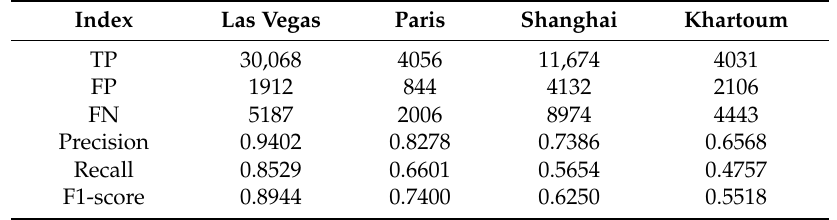
Table 5. Results of proposed method evaluated by the dataset provided in the final phase.